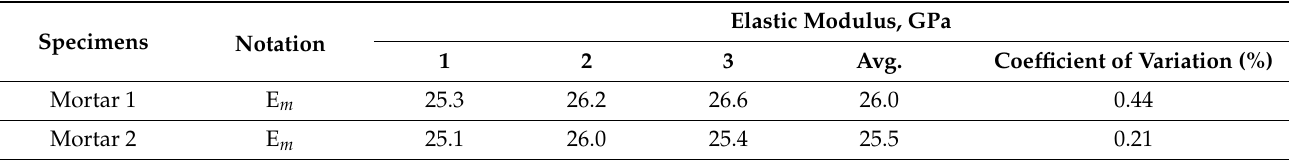
Table 4. Elastic modulus of